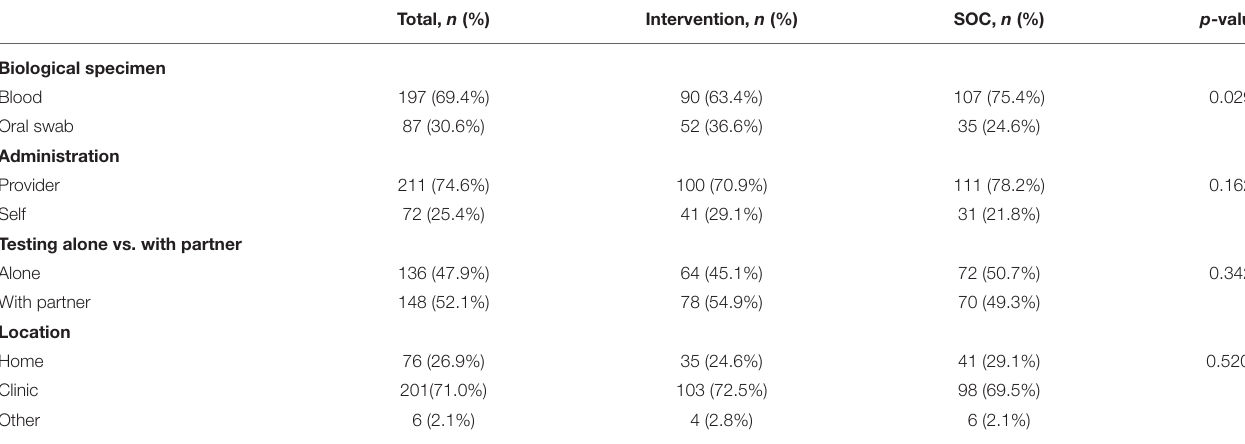
TABLE 3 | Preferred attributes of HIV testing programs for future